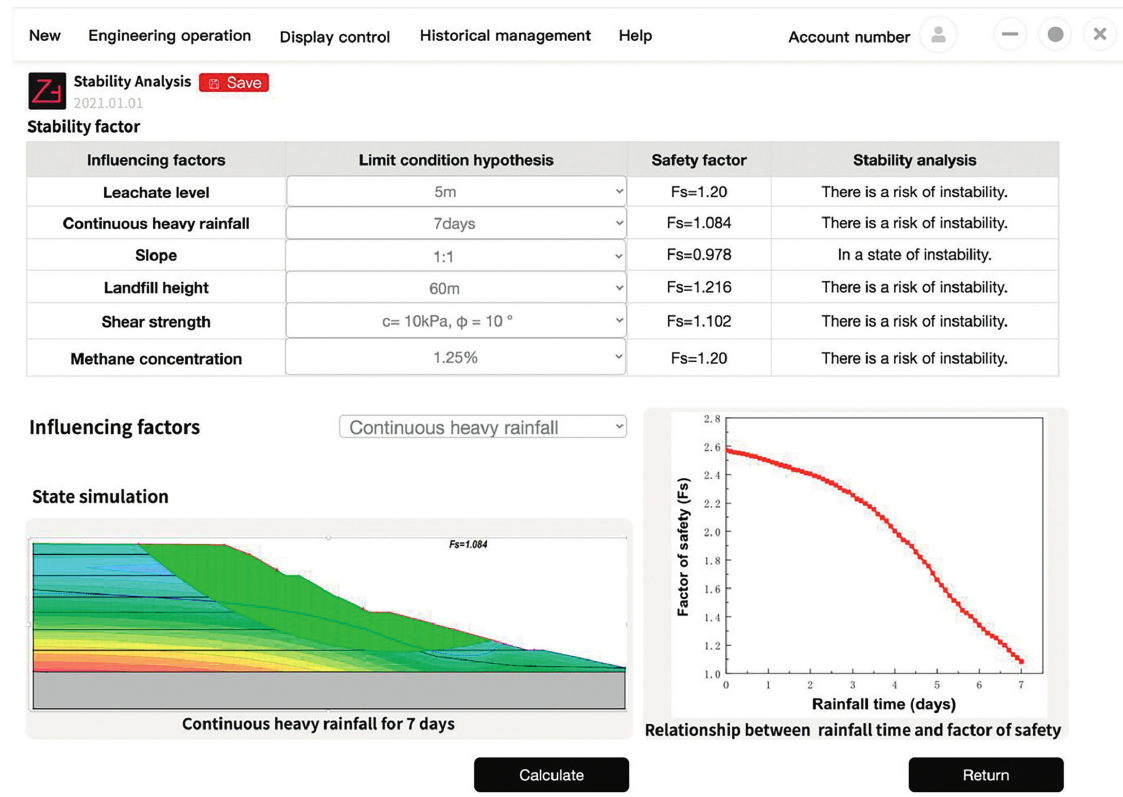
Figure 6: Landfill stability